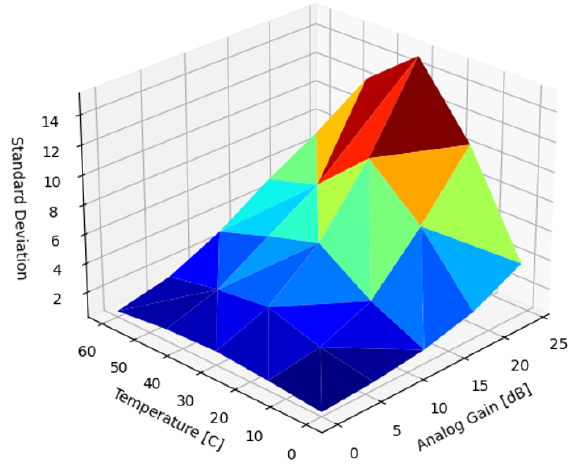
Figure 13. SD of DSNU corrected with linearly interpolated reference, using 4 reference captures.